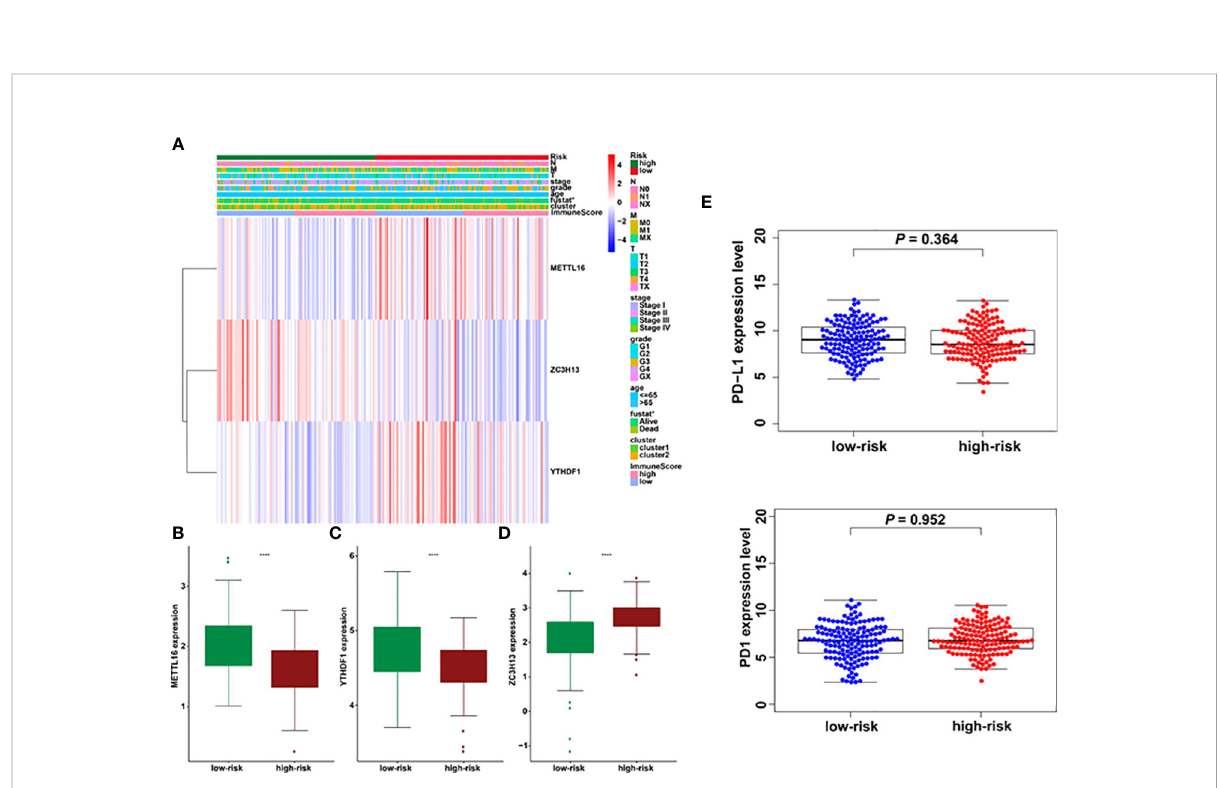
FIGURE 8 Prognostic riskscores correlated with stage, immunescore, and clinicopathological parameters in cervical cancer. (A) Heatmap and clinicopathologic parameters of high- and low-risk groups. (B – D) The differences of METTL16, YTHDF1, and ZC3H13 expression in low- and high-risk groups. (E) The relationship between riskscore and PD-L1 expression *p < 0.05; ****p <